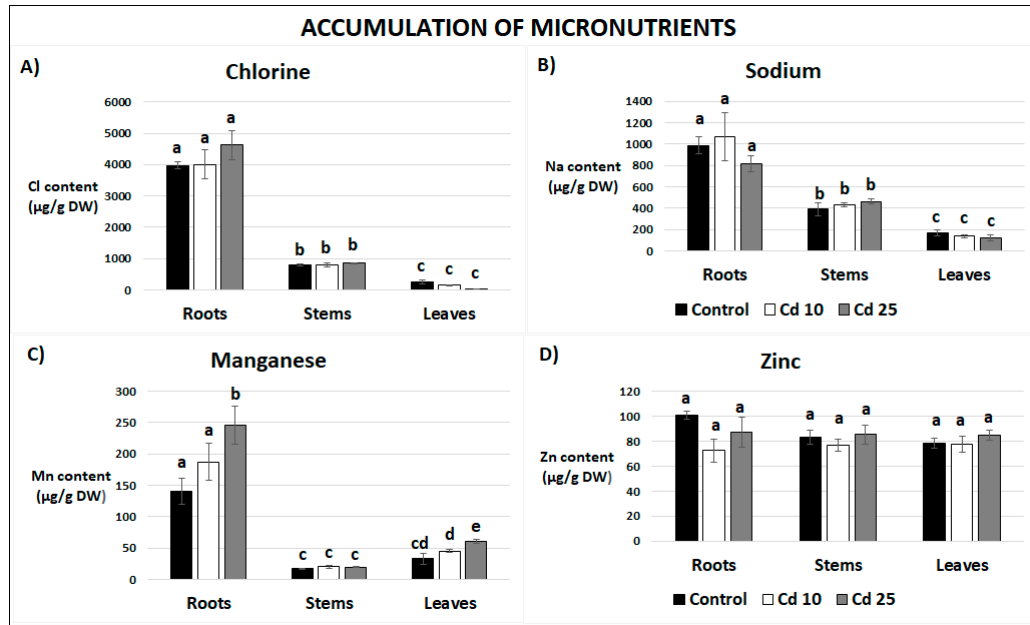
Figure 7. Content of micronutrients, chlorine ( A ), sodium ( B ), manganese ( C ) and zinc ( D ) in plants after 7 days of recovery periods. Results are the means of three independent experiments ± SE. Results showing no statistically significant differences by p = 0.05 are marked with the same letter.